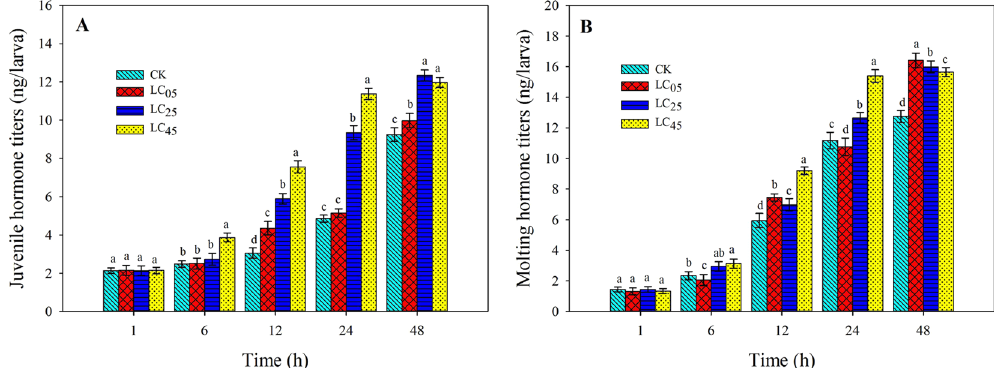
Figure 9. Hormone titers ( A ) juvenile hormone titers, ( B ) molting hormone titers) in A. ipsilon larvae after treatment with chlorantraniliprole. Bar with the same lowercase letters show no significant differences (Student- Newman-Keuls test, P <